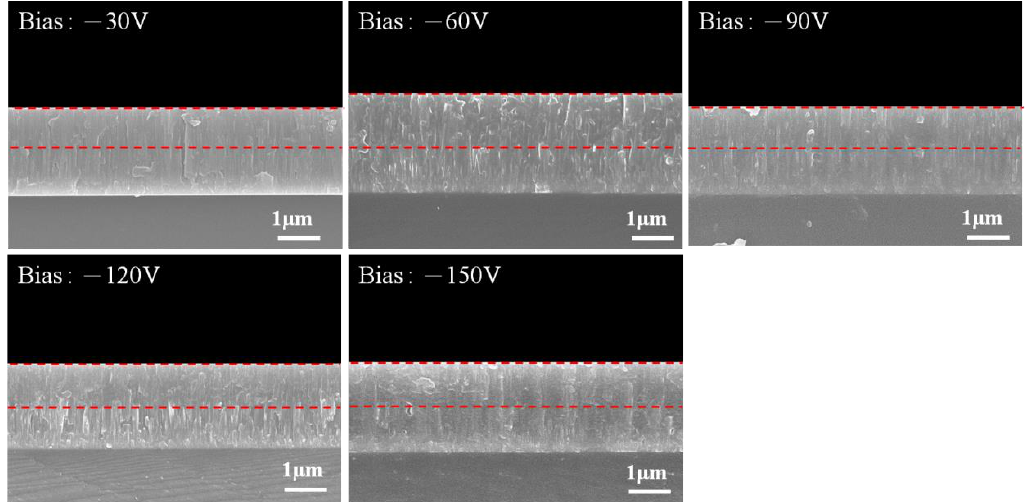
Figure 7. Cross-sectional SEM images of coatings deposited under various bias voltages.